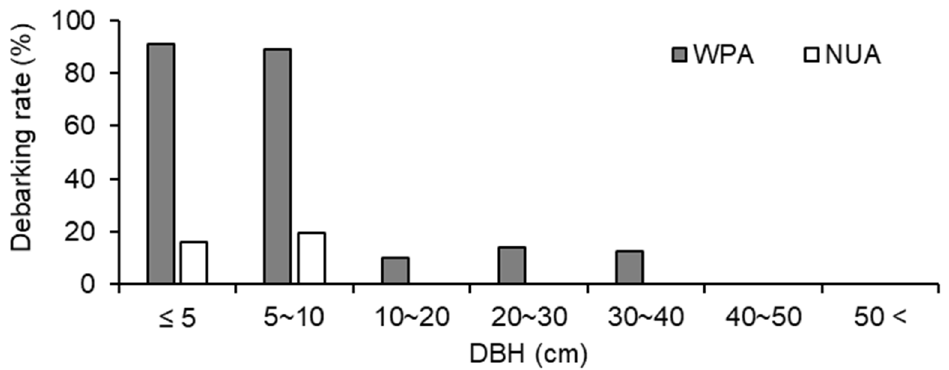
Figure 5. Debarking rates for all trees ≥ 1.5 m tall at a wildlife protected area (WPA) and the neighboring unprotected area (NUA) in 2011. Table 1. Density of broad-leaved seedlings 0.5–1.5 m tall and canopy openness (±SE) at a wildlife protected area (WPA) and the neighboring unprotected area (NUA) in 2011.